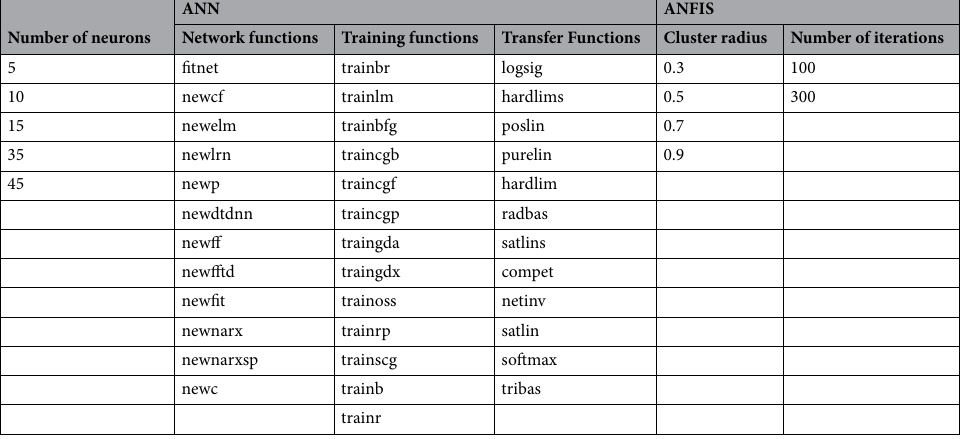
Table 4. Different parameters used to optimize the